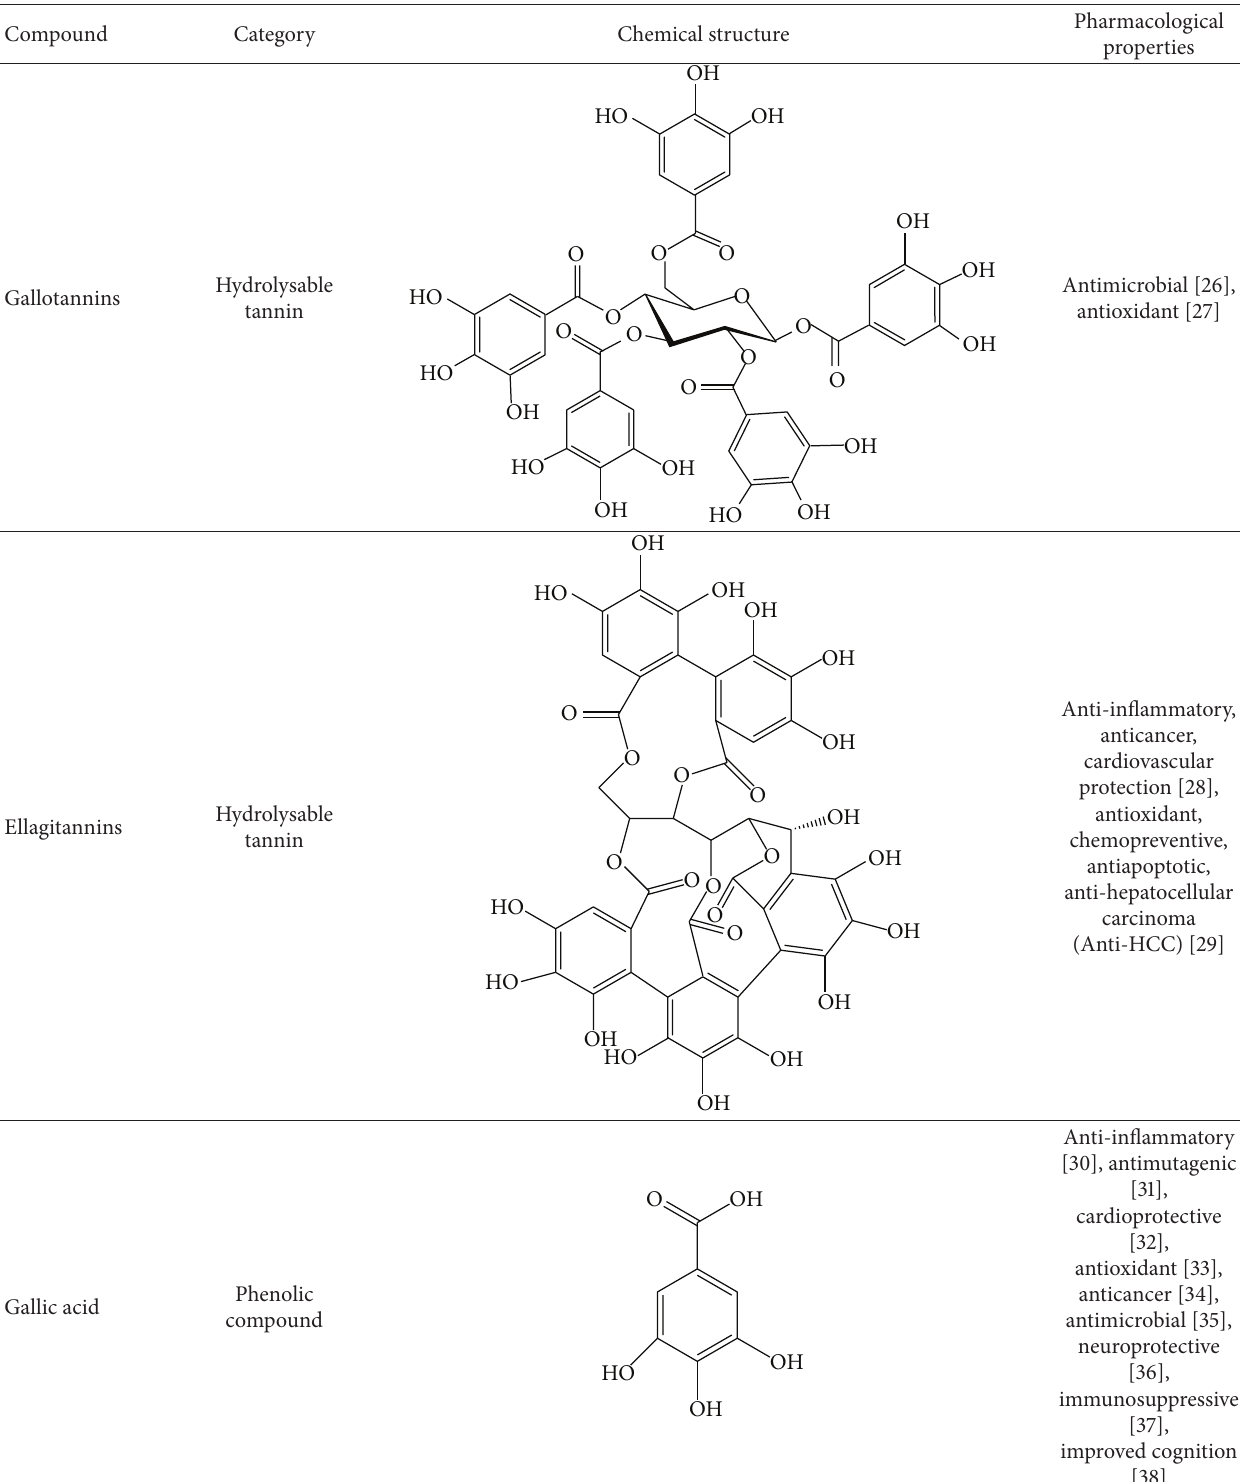
Table 1: Structure and pharmacological properties of T . chebula active